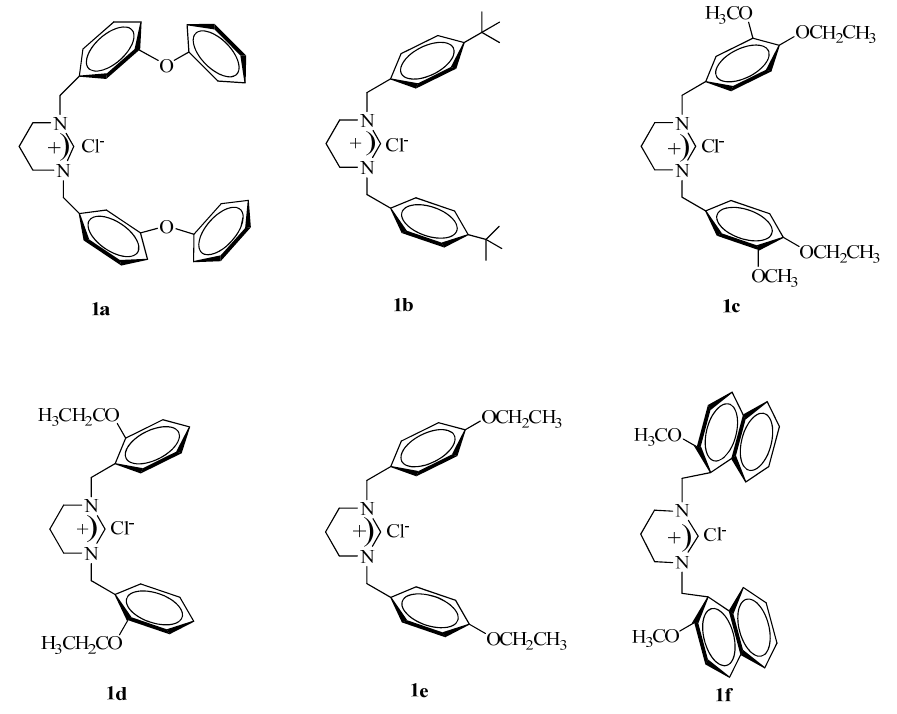
Figure 1. Tetrahydropyrimidinium